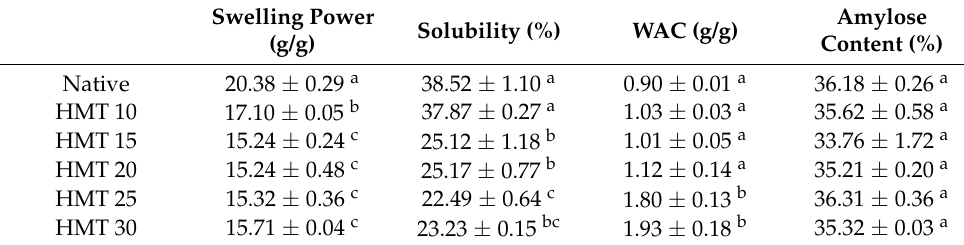
Amylose Content (%)